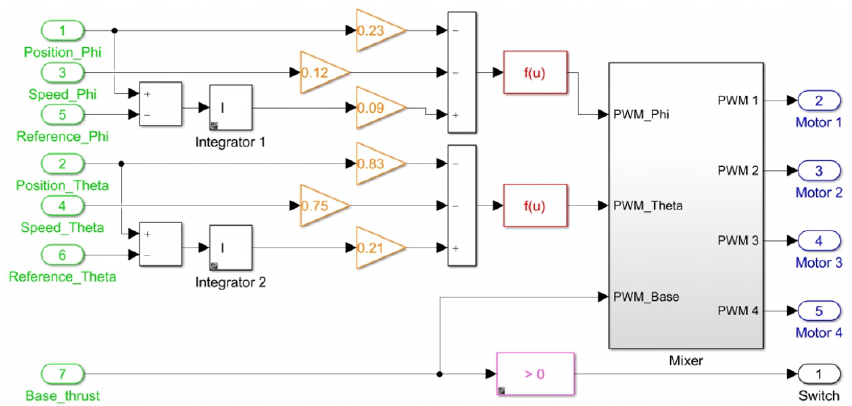
Figure 16. Block diagram in “Control algorithm” subsystem for state feedback controller implementation.